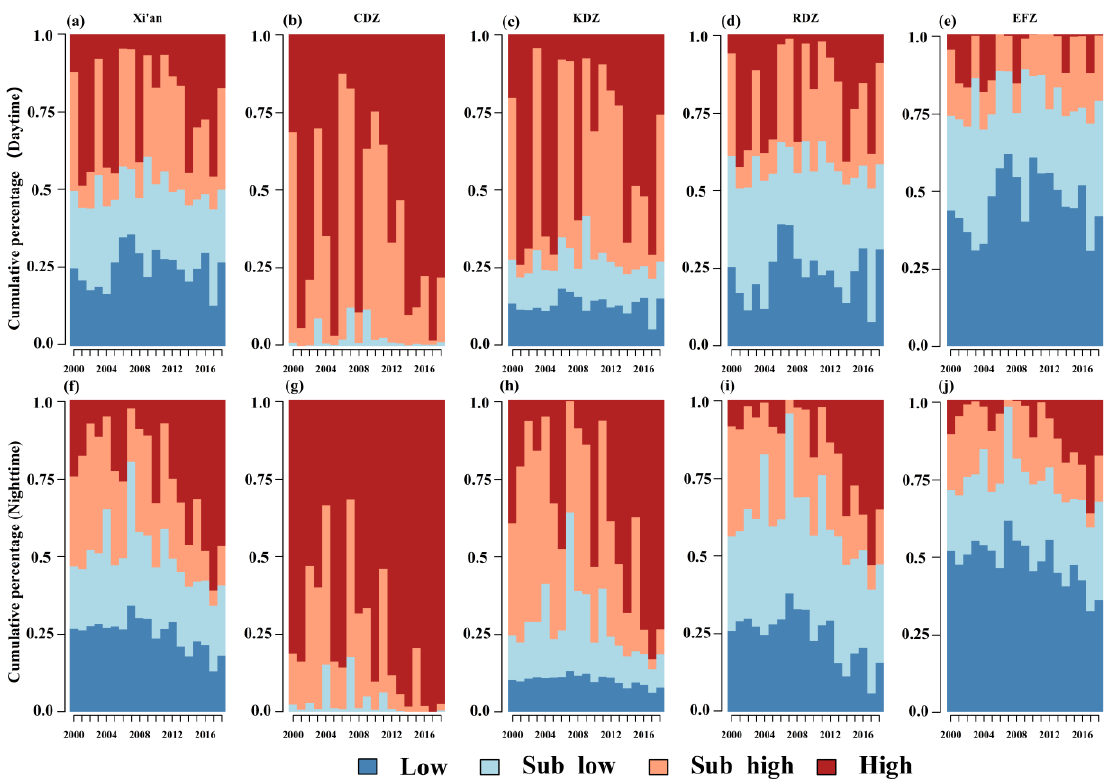
Figure 4. The cumulative percentages of areas in different land surface temperature categories (low (less than the first quartile), sub-low (between the first and second quantiles), sub-high (between the second and third quartiles), and high (between the third and fourth quartiles)) in the four functional districts and the whole city during the daytime and nighttime from 2000 to 2018, respectively.